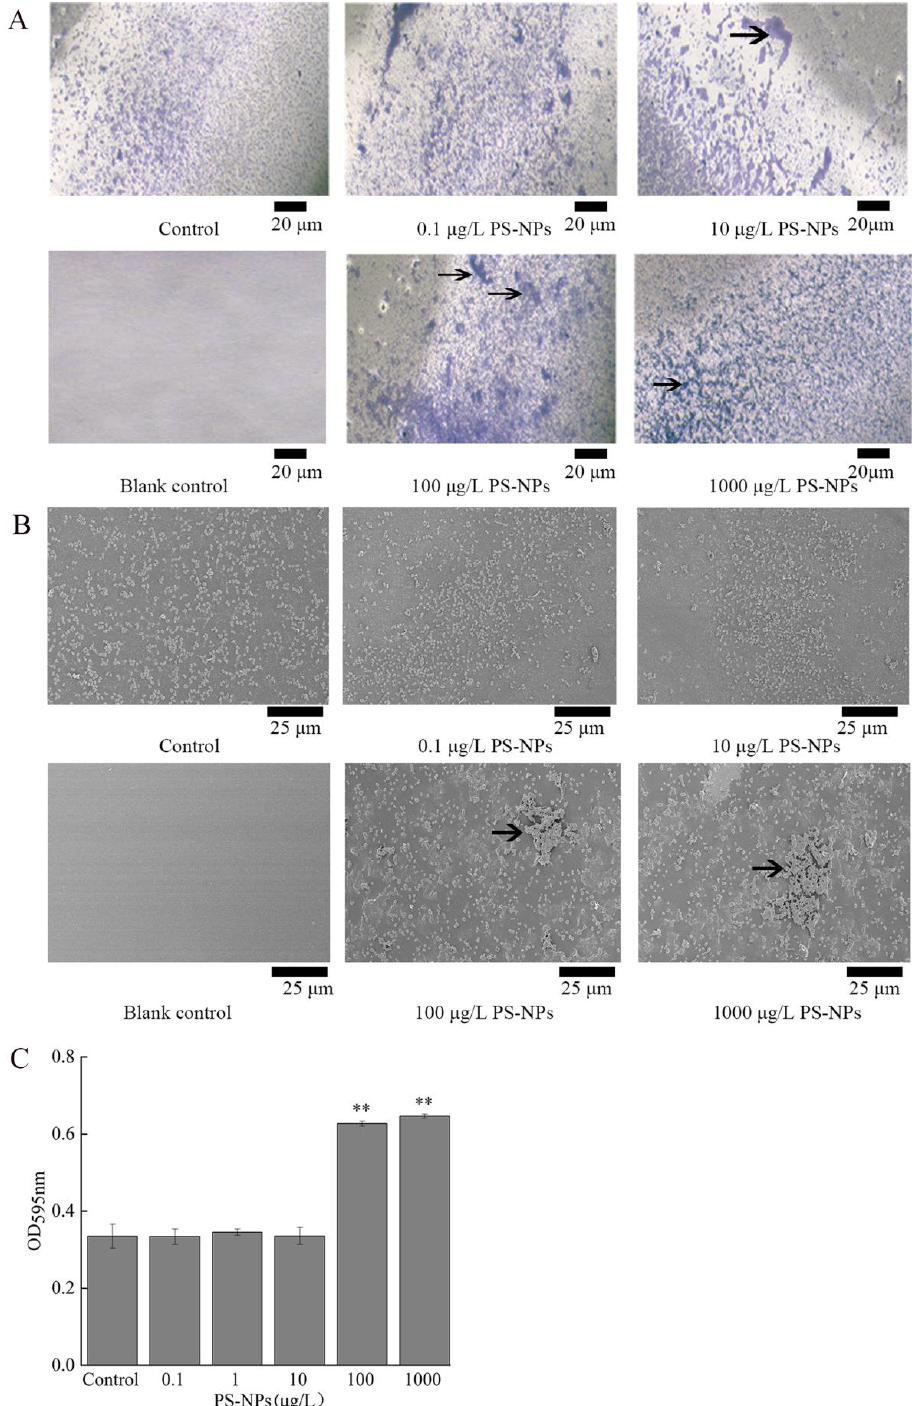
Figure 5. Effect of nanopolystyrene particle (NP) exposure at concentrations of 0.1–1000 µ g/L on A. johnsonii AC15 biofilm formation. ( A ) Crystal violet staining images showing the effect of NP exposure at different concentrations on A. johnsonii AC15 biofilm formation. Arrowheads indicate the formed biofilm. ( B ) Scanning electron microscopy (SEM) images showing the effect of NP exposure at different concentrations on A. johnsonii AC15 biofilm formation. Arrowheads indicate the formed biofilm. ( C ) Effect of NP exposure at different concentrations on the amount of A. johnsonii AC15 biofilm formation based on the analysis of OD values of 595 nm. Blank control, without crystal violet staining. ** p < 0.01 vs.